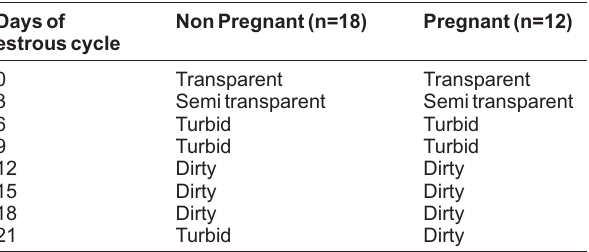
Table-2. Colour of cervico-vaginal mucus in pregnant and non pregnant animals. Day 0 = day of estrus, Day 3-21= days of estrous cycle